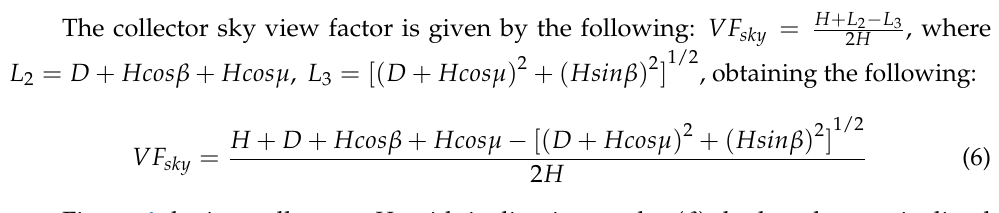
Figure 5. Collectors, 𝐻 , mounted on triangle shapes on a horizontal plane.